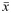
Ketoconazole and antimony combination on L. (L.) amazonensis amastigotes.Isobologram representing in vitro ketoconazole-antimony interaction against L. (L.) amazonensis free (A) or intracellular (B) amastigotes by a fixed-ratio method based on the IC50. Dashed line represents an ideal theoretical line for the additive effect; the x¯ΣFIC50 for all interactions tested is also shown. Concentration-effect curves concerning the inhibition of L. (L.) amazonensis free (C) and intracellular (D) amastigotes by different combinations of antimony (black points) and ketoconazole (white points). Data represent mean ± SEM of two independent experiments performed in triplicate.